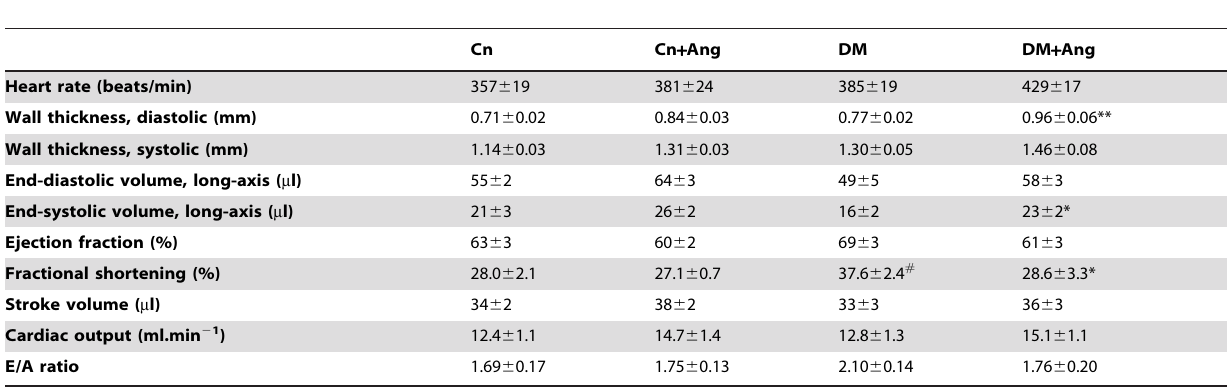
Table 2. Echo pulse-doppler determination of changes in cardiac dimensions and cardiac performance in non-diabetic (Cn) and diabetic (DM) mice treated with vehicle or angiotensin II (Ang) for 4 weeks.